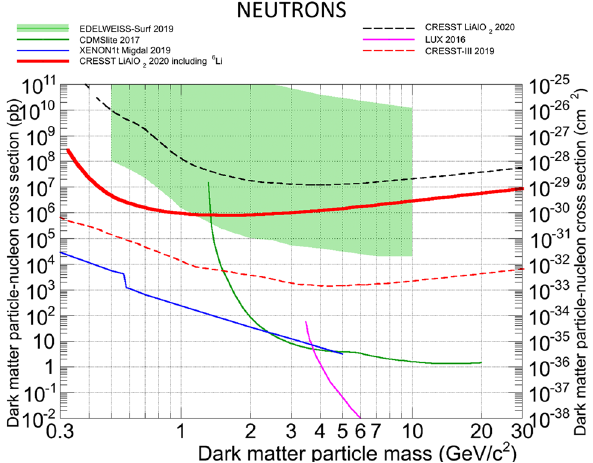
Fig. 2 Exclusion limits set by various direct detection experiments for spin-dependent interactions of dark matter particles with neutrons. The result obtained from module B data with 7 Li + 27 Al is shown with a dashed black line [9]. The new result obtained with 6 Li + 7 Li + 27 Al is shown withasolidredline.Theresultobtainedwith 17 OinCRESST-III is shown with a dashed red line [1]. For comparison, limits from other experiments are also shown: EDELWEISS [29] and CDMSlite [24] using 73 Ge, LUX [30] and XENON1T (Migdal effect) [26] using 129 Xe + 131